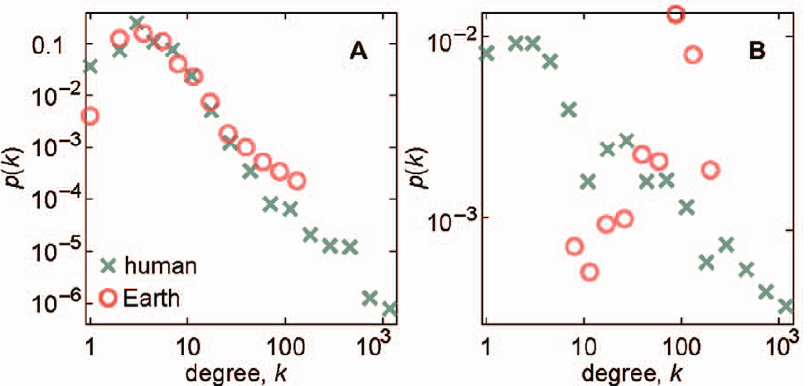
Figure 1. Degree distributions of substance and reaction graphs of the human metabolism and Earth’s atmospheric reaction system. Panel A shows the probability mass-function of the degree of the substance graph of the reaction system of the Earth’s atmosphere and the human metabolic networks. B shows the same as A, but for the reaction network. The similar behavior in A is drastically different in B. The plots are log-binned and plotted on double logarithmic scales.